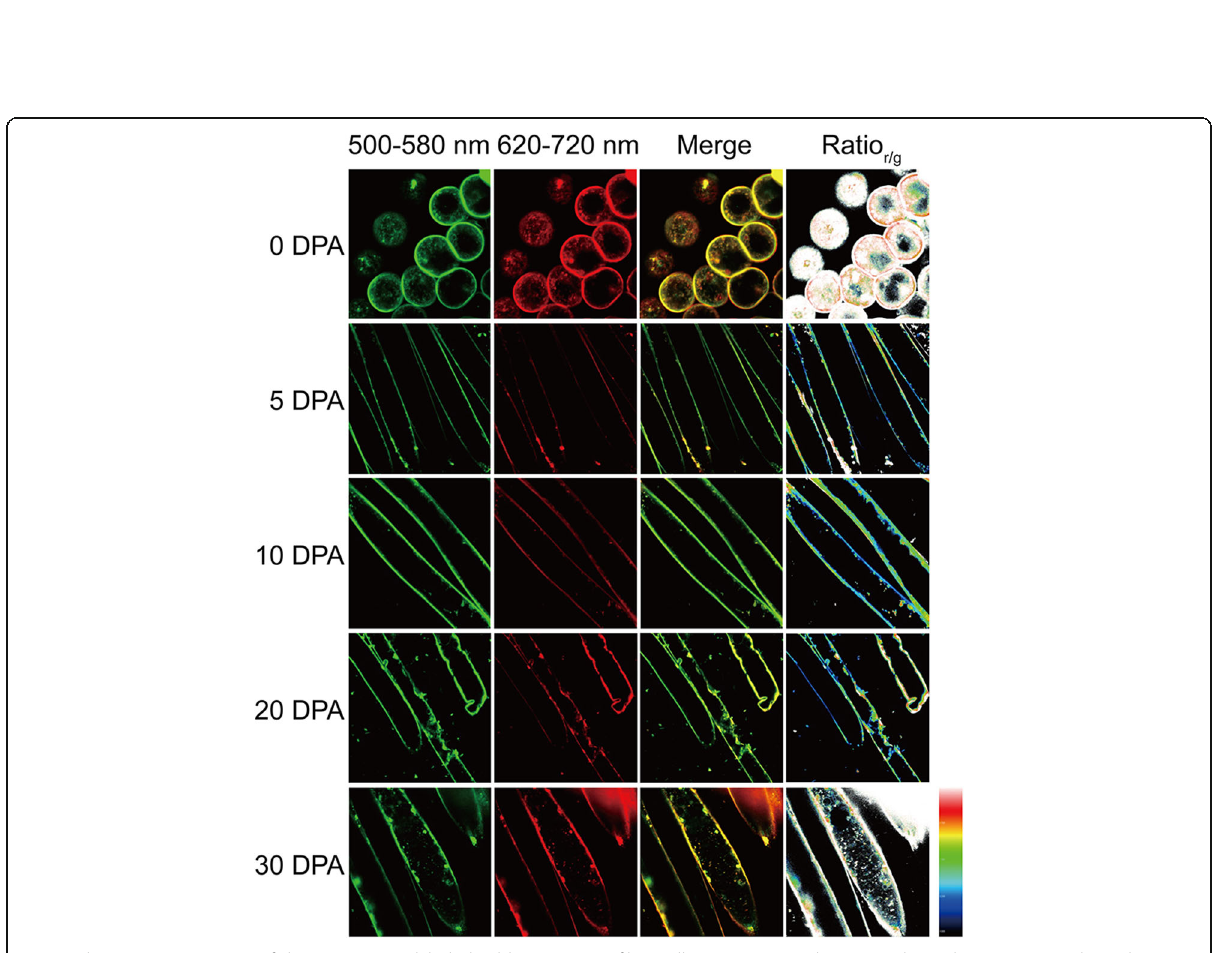
Fig. 4 Fluorescence imaging of di-4-ANEPPDHQ labeled wild-type cotton fiber cells. 500 – 580 nm, the green channel; 620 – 720 nm, the red channel; Merged, the merged channel of green and red channels; Ratio, the ratio images of red channel/ green channel. 0 DPA, 5 DPA, 10 DPA, 20 DPA, 30 DPA represent the period of cotton fiber cell